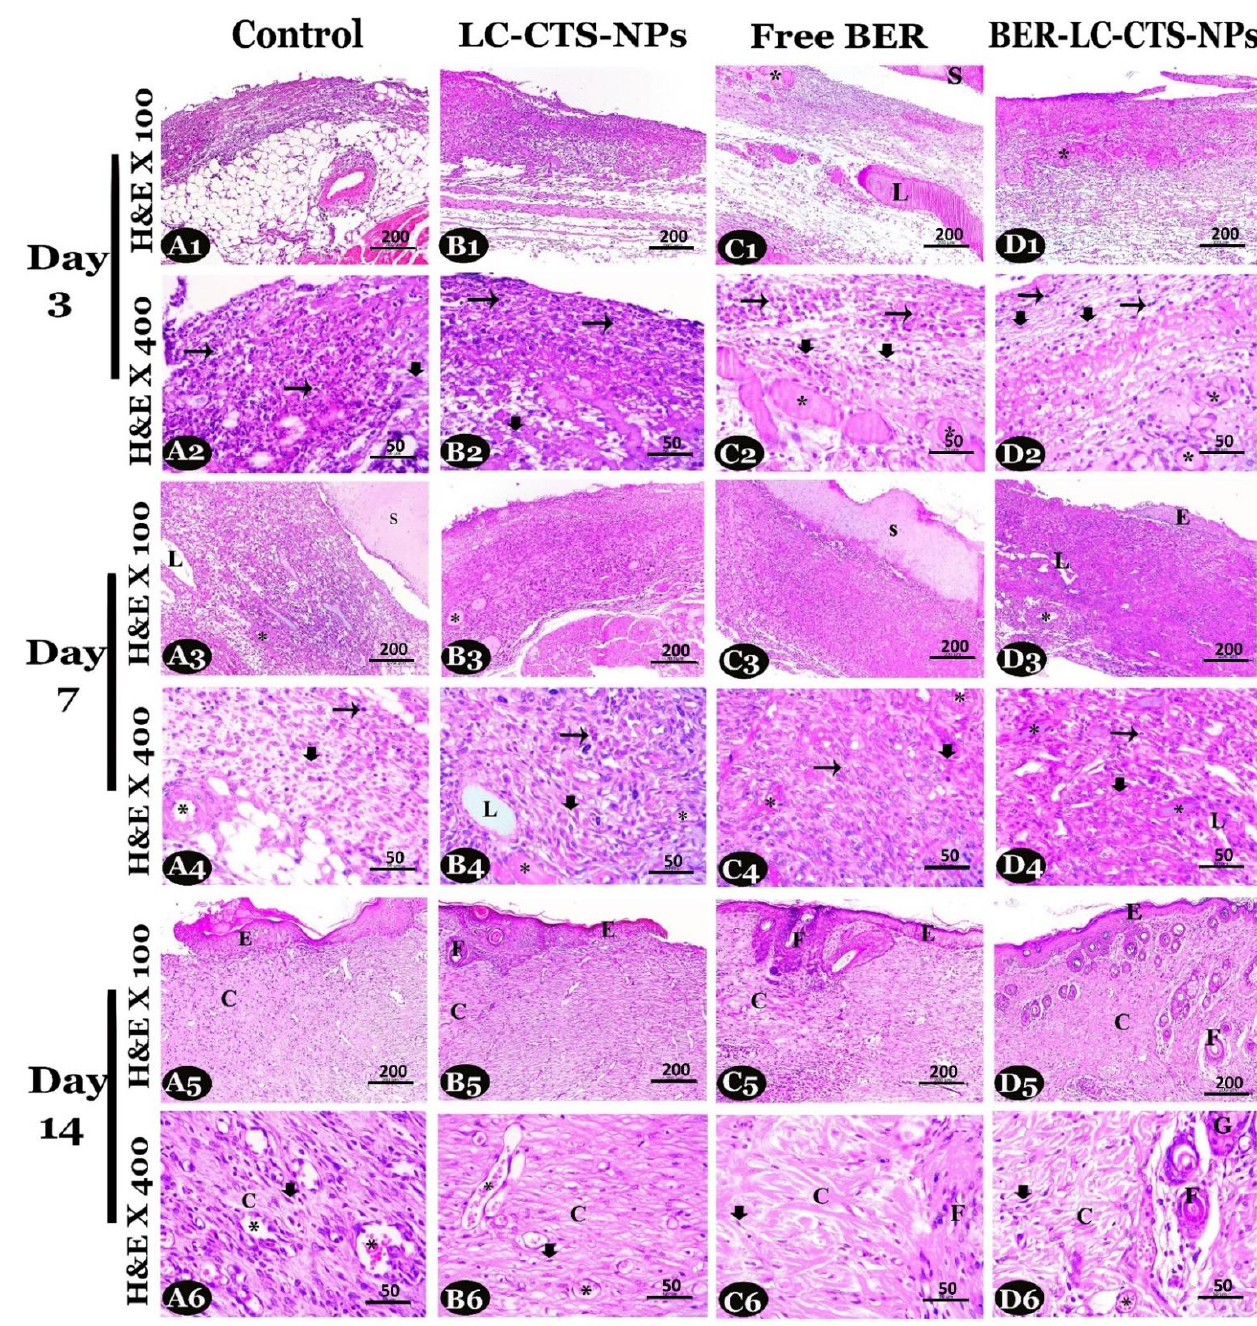
Figure 8. Photomicrographs of H&E stained skin sections (1st, 3rd and 5th rows × 100, and 2nd, 4th and 6th rows × 400) on days 3, 7 and 14 post wound creation in the diabetic rats of the Control ( A1 – A6 ), LC-CTS-NPs ( B1 – B6 ), Free BER ( C1 – C6 ) and BER-LC-CTS-NPs ( D1 – D6 ) groups. Note: inflammatory cells (long arrows), fibroblast proliferation (thick arrows), blood vessels (*), lymph vessels (L), scar (S), newly formed epidermis (E), collagen fibers (C), hair follicles (F), and sebaceous gland (G).